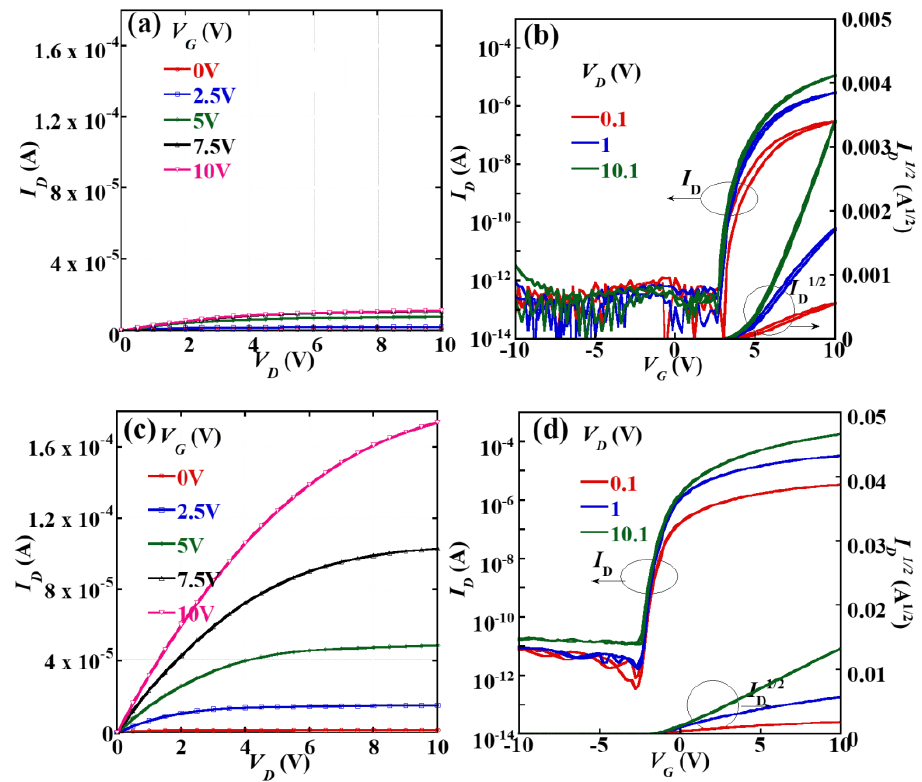
Figure 5. ( a ) Output and ( b ) transfer characteristics for the printed InGaO TFT; ( c ) output and ( b ) transfer characteristics for the printed InGaSnO TFT.